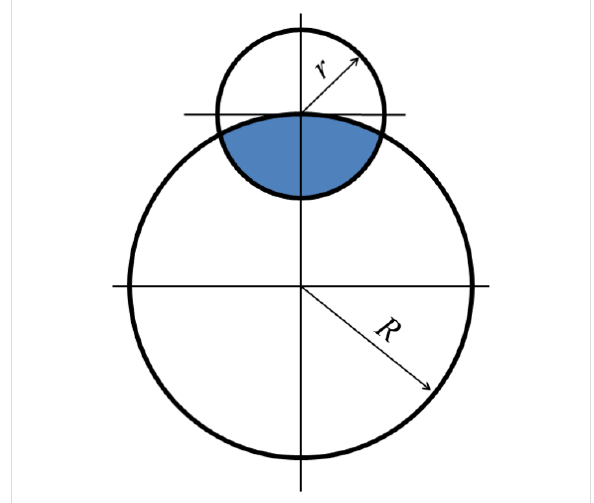
Figure 2: Visualization of the setting for the estimation the number of next neighbors (coordination number) of an atom at the surface of a spherical particle with diameter d = 2 R . The volume of the intersection of this sphere with a second sphere of the radius r, representing the distance to the next neighbors, allows an approximation for the possible number of next